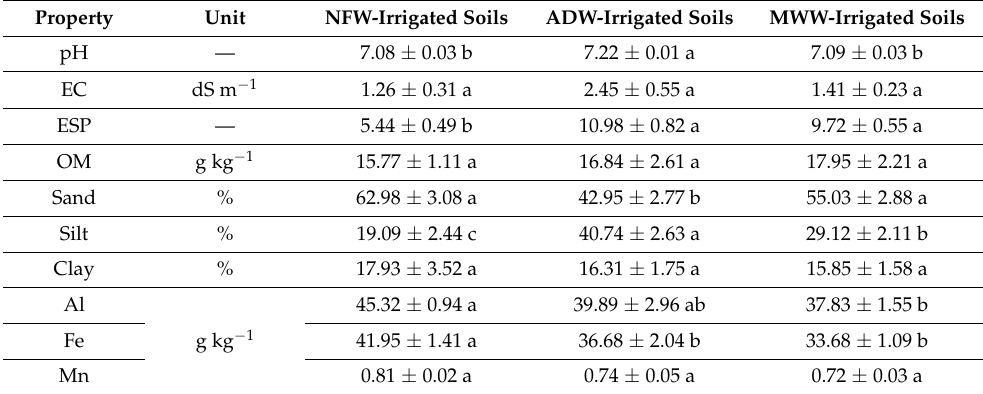
Table 1. Soil physicochemical